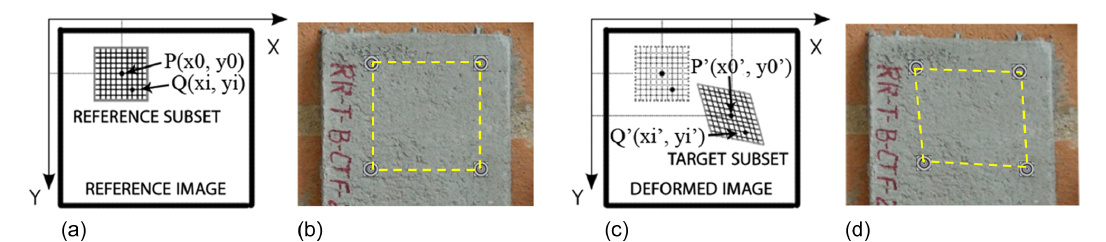
Figure 4. Illustration of the basic principle of the digital image correlation method: sketch of the subset ( a,c ) and measurement points on the surface of a specimen ( b,d ) before ( a,b ) and after ( c,d ) deformation [36].